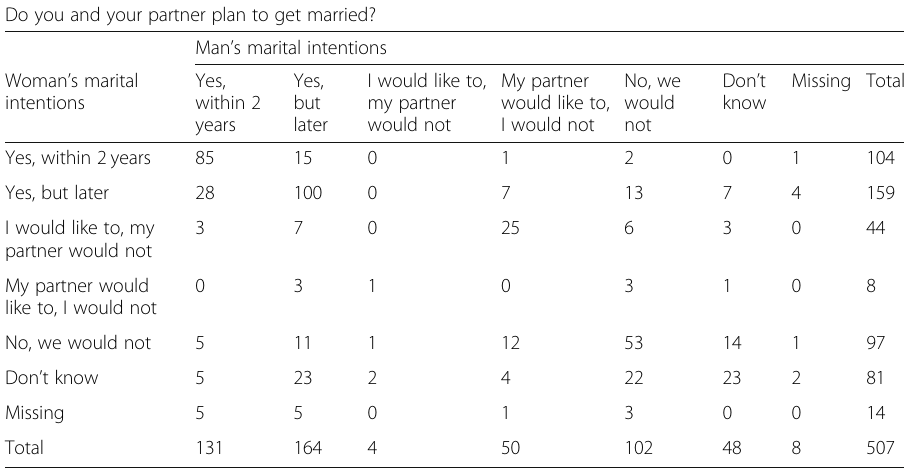
Table 1 Women ’ s and men ’ s marital intentions (number of couples = 507) Do you and your partner plan to get